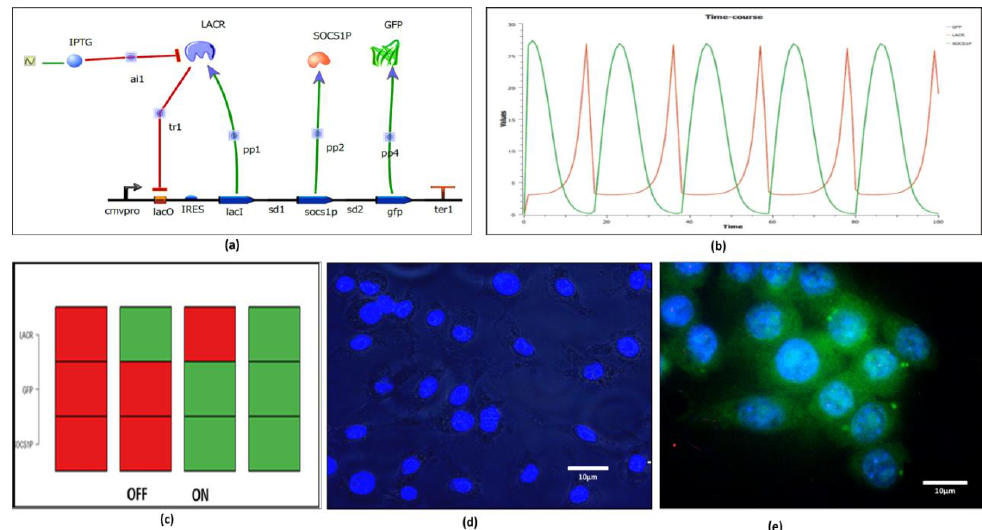
Figure 7. Synthetic circuit Design: ( a ) Modular arrangements of biological parts to receive an output in Tinker Cell. ( b ) After simulating the system, the output is received in the form of oscillatory behavior of LACR, Peptide8 and GFP. ( c ) Attractor states of synthetic circuits show its ON and OFF stage. Plasmid was transfected and expressed in the RAW264.7 cell line, through IPTG induction, followed by DAPI staining. ( d ) OFF stage of the system in vitro (no IPTG induction). ( e ) ON stage of the system in vitro (with IPTG induction).